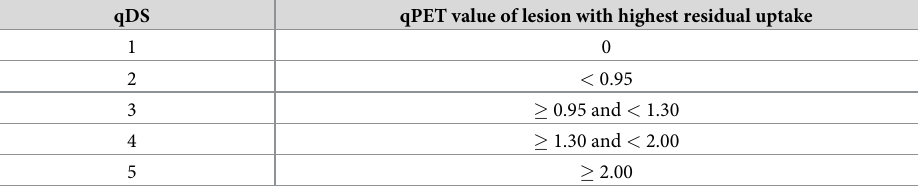
Table 1. Classification of the quantitative Deauville score (qDS) according to the qPET value.